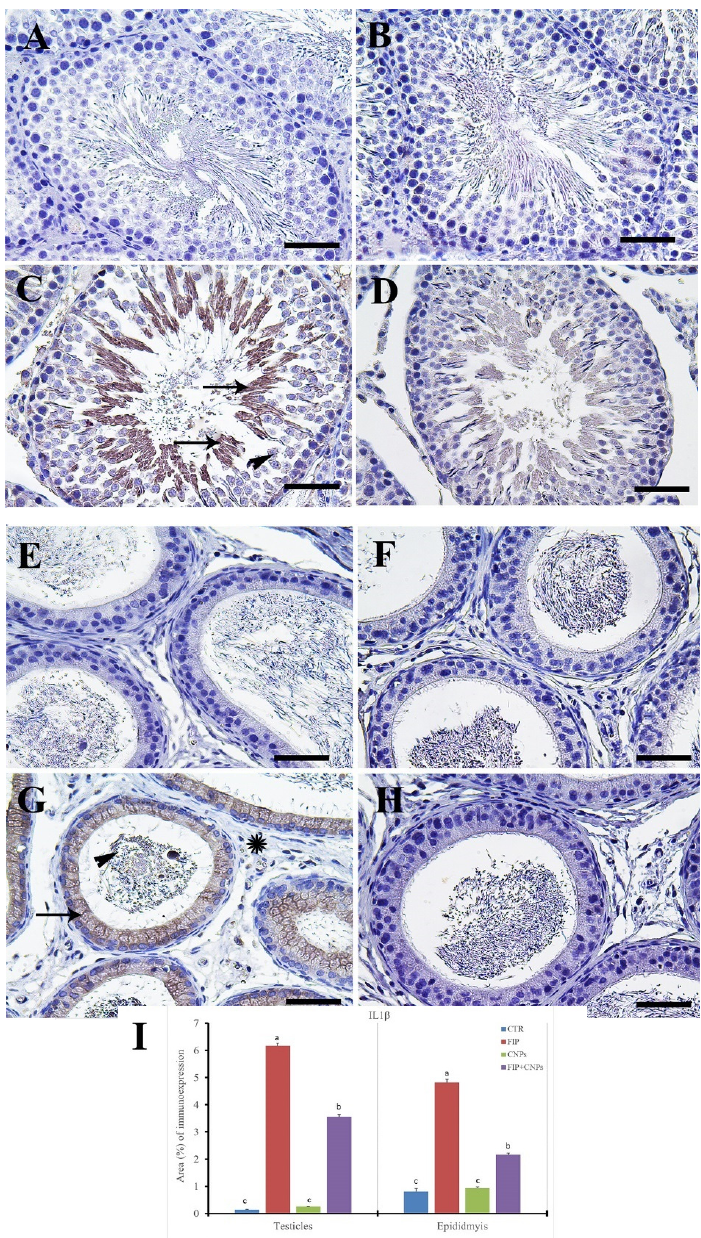
Figure 5. Immunohistochemical staining of rat testes by Interleukin-1 β (IL-1 β ). ( A ) control group. ( B ) CeNPs group. ( C ) FIP group showed strong IL-1 β reaction in sperms (arrows), while the remaining spermatogenic cells revealed negative reactions (arrowhead). ( D ) FIP-treated with CeNPs showed very weak IL-1 β reaction (arrow). ( E ) Epididymal of control group. ( F ) CeNPs group. ( G ) FIP group showed strong positive IL-1 β reaction (arrow) and faint to negative reaction in the spermatozoa (arrowhead) and interstitial connective tissue (asterisk). ( H ) FIP-treated with CeNPs. ( I ) Semi-quantification of IL-1 β in the testicular and epididymal tissues in different groups. Scale bar = 50 µm . Data expressed as mean ± SE, analyzed using one-way ANOVA at p ≤ 0.05.